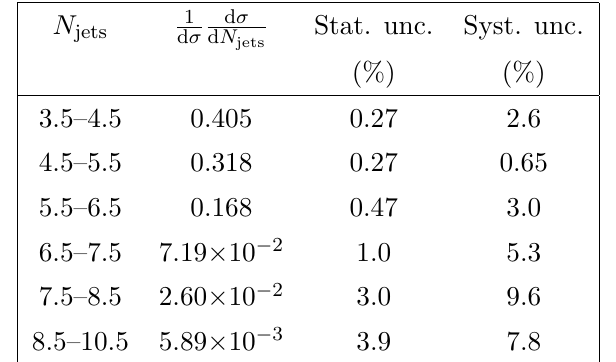
Table 4 . Results of the normalised di(cid:11)erential cross sections with relative uncertainties in the combined channel with respect to N jets .